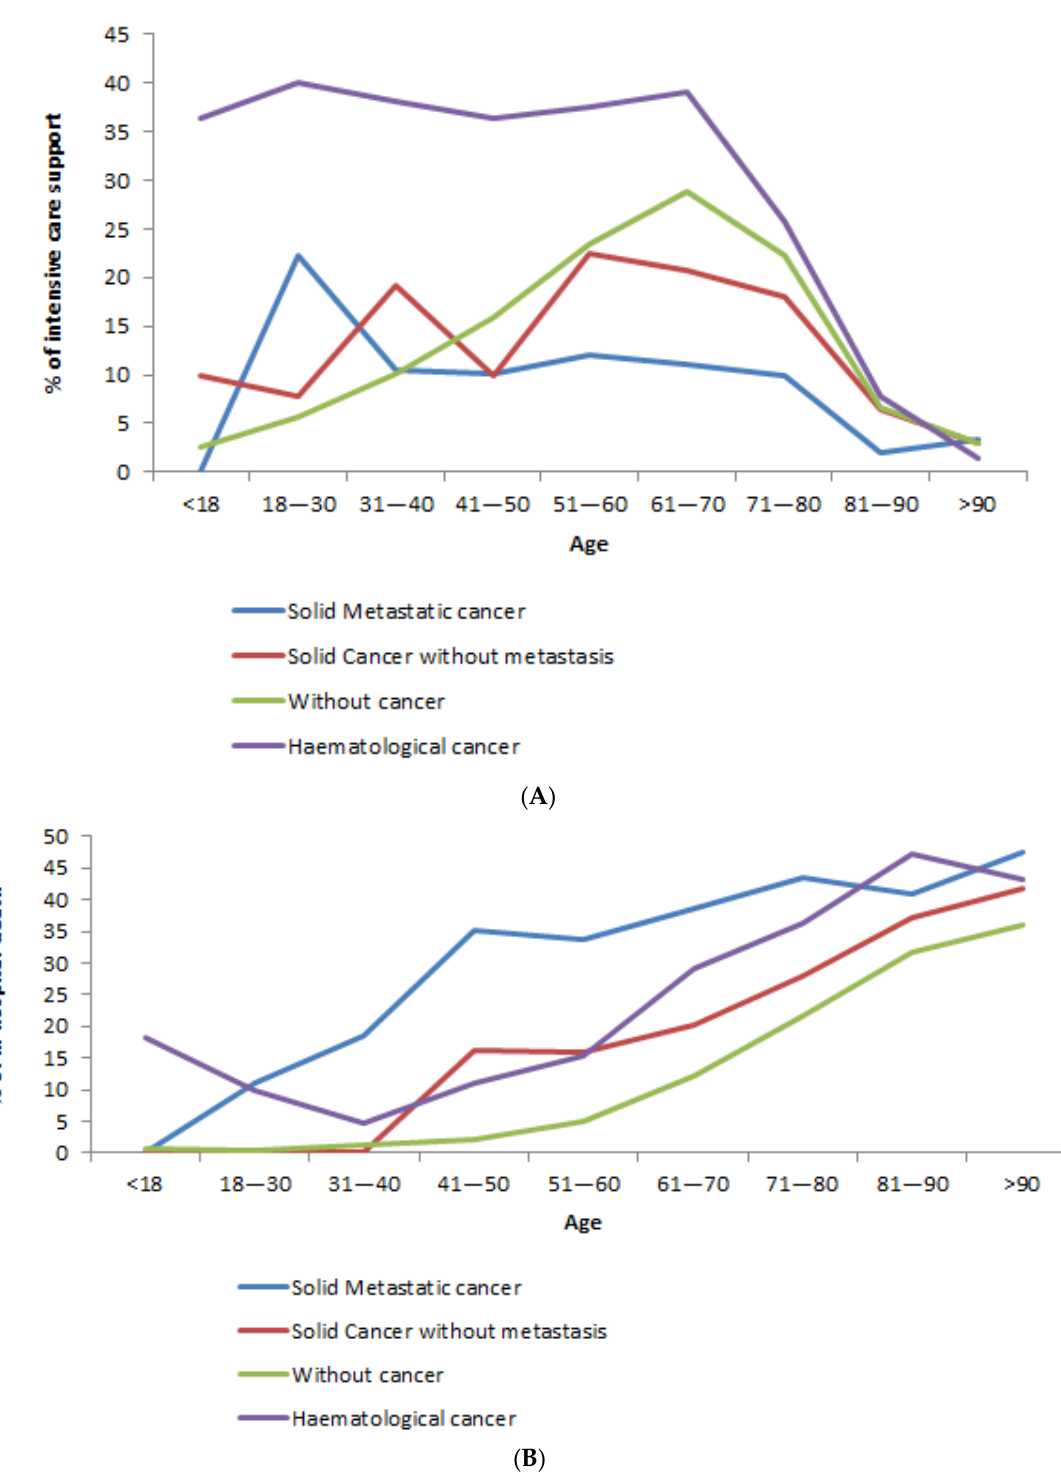
Figure 1. ( A ) . Intensive care support rates of patients hospitalized in France for COVID-19 (from 1 March 2020 to 30 April 2020) for cancer (with or without metastasis) or not, according to their age at admission. ( B ) . Hospital mortality rates of patients hospitalized in France for COVID-19 (from 1 March 2020 to 30 April 2020) for cancer (with or without metastasis) or not, according to their age at admission. Table 5. Logistic regression to study the risk of hospital death among cancer patients hospitalized in France for COVID-19 (from 1 March 2020 to 30 April 2020), using colorectal cancers as the reference group. n Death Hospital Mortality Rate